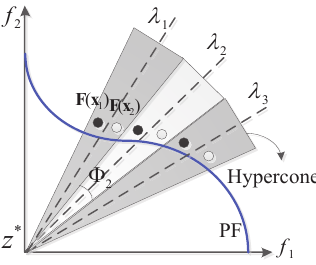
Figure 4. Demonstration of the localized localized penalty-based boundary intersection (LPBI)